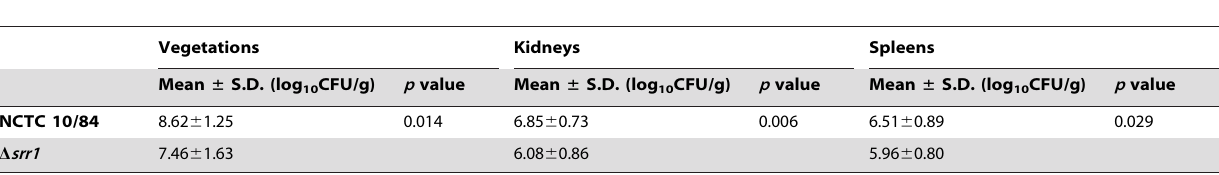
Table 2. Impact of Srr1 on virulence in an animal model of endocarditis.